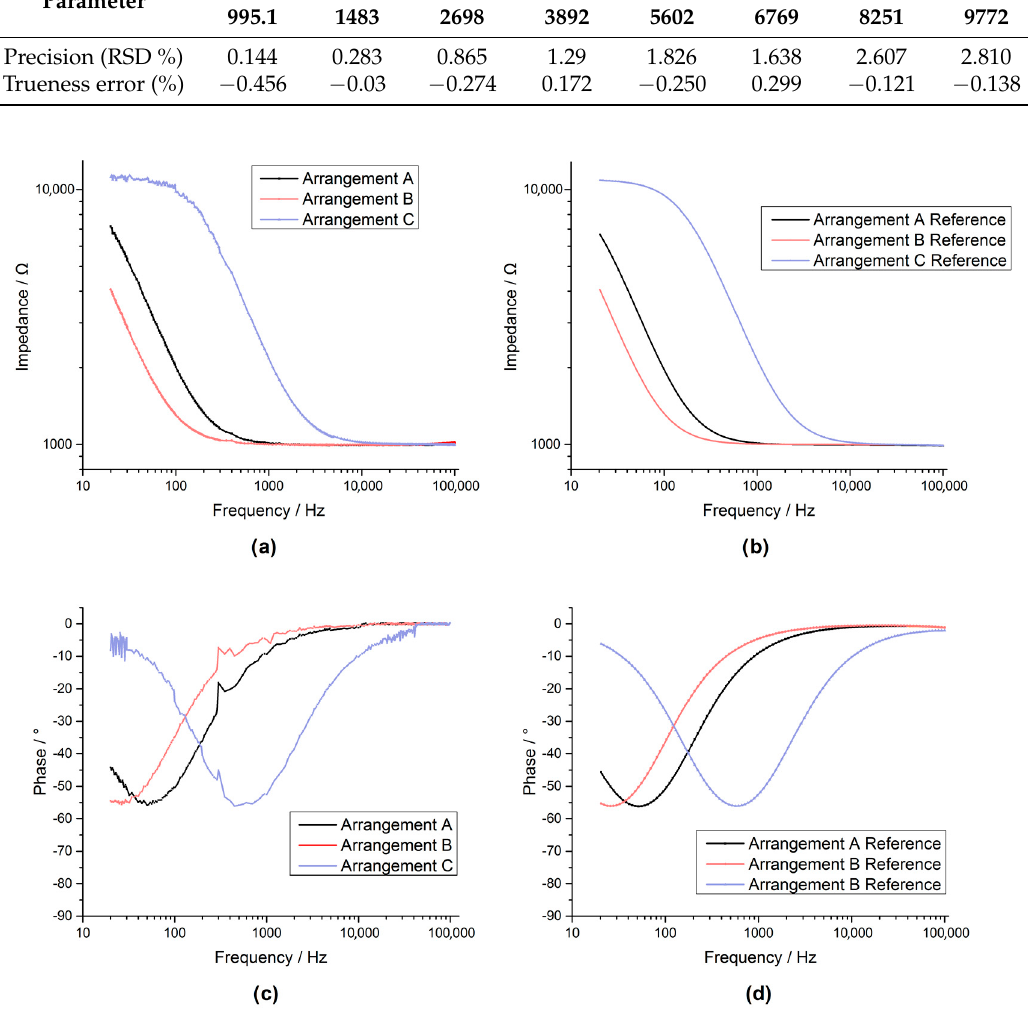
Figure 22. The Bode plot for the arrangements A, B, C recorded with the AD5933 custom system are shown in figures ( a , c ), while the bode plots for the same arrangements recorded by an Autolab PGSTAT302N impedance module are shown in figures ( b , d ).